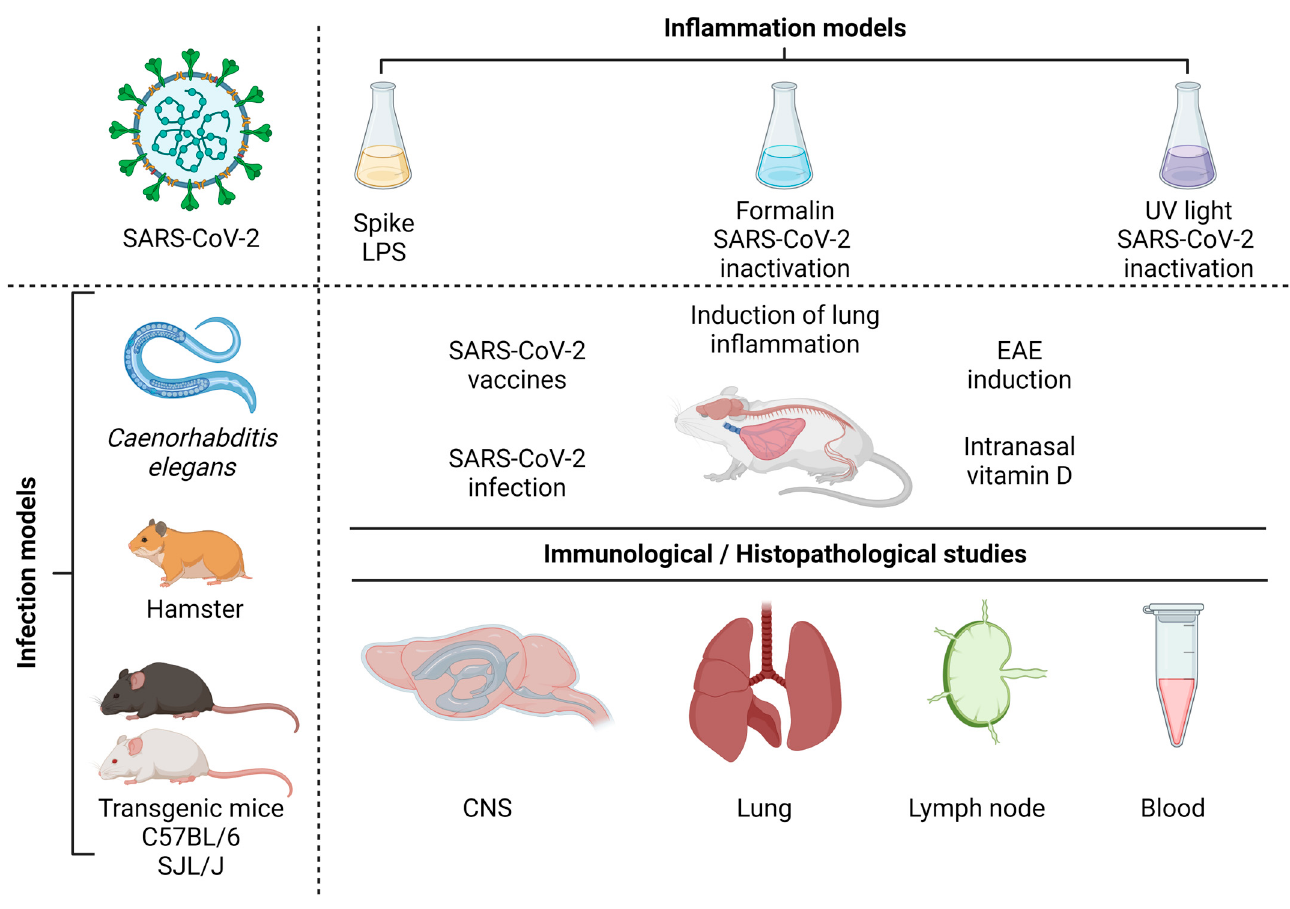
Figure 6. Infection models and immunological/histopathological studies. Source: Created with Biorender.com.